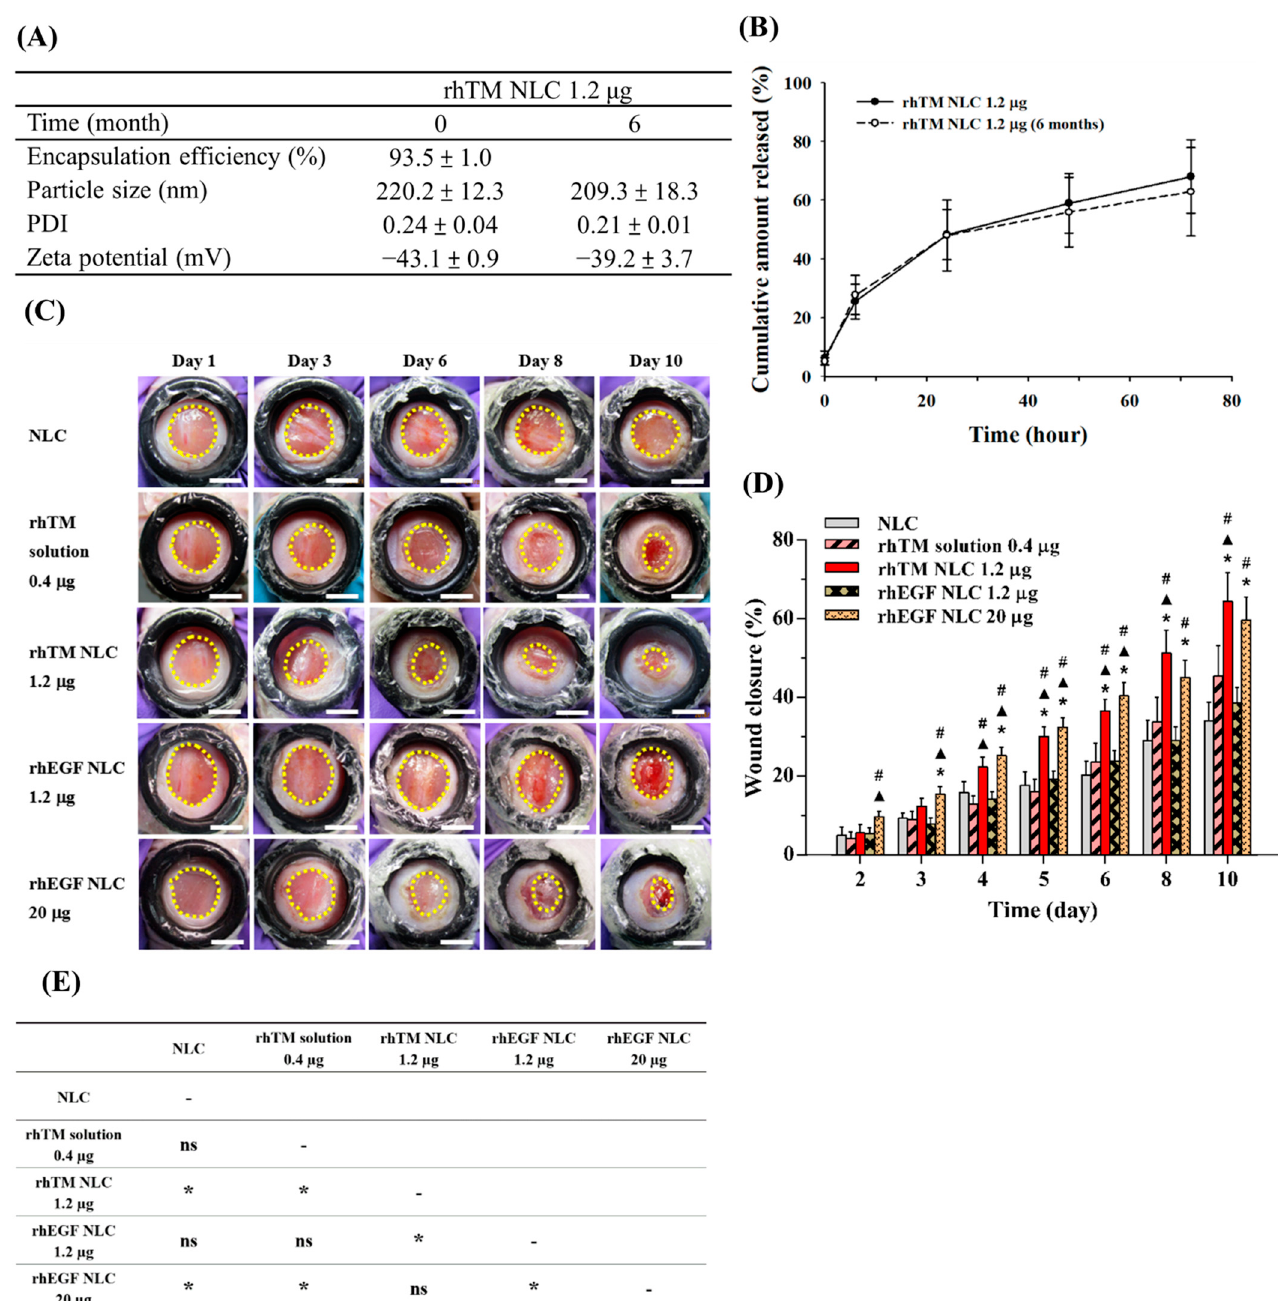
Figure 2. Characterization and wound healing effect of rhTM NLC 1.2 µg. ( A ) Physical characteristics of rhTM NLC 1.2 µg ( n = 3). Data presented as mean ± SD. ( B ) In vitro drug release of freshly prepared rhTM NLC 1.2 µg and after storage at 4 °C for 6 months. Data presented as mean ± SD. ( C ) Representative wound area of streptozotocin-induced diabetic mice at Day 1 to 10 with different treatments. ( n = 6–15 for each group; Scale bar = 5 mm). ( D ) Wound closure rate by quantifying wound area and analyzing with mathematical formula described in Methods. Data presented as mean ± SEM. The significance was analyzed using Student’s t test. p < 0.05 compared with NLC group (*), rhTM solution 0.4 µ g group ( (cid:78) ), or rhEGF NLC 1.2 µ g group (#). ( E ) Multiple comparison analysis of wound closure effect between different treatment groups based on general linear model. Data presented as p value. Bonferroni post hoc test was applied. (*: p < 0.05; ns: p >